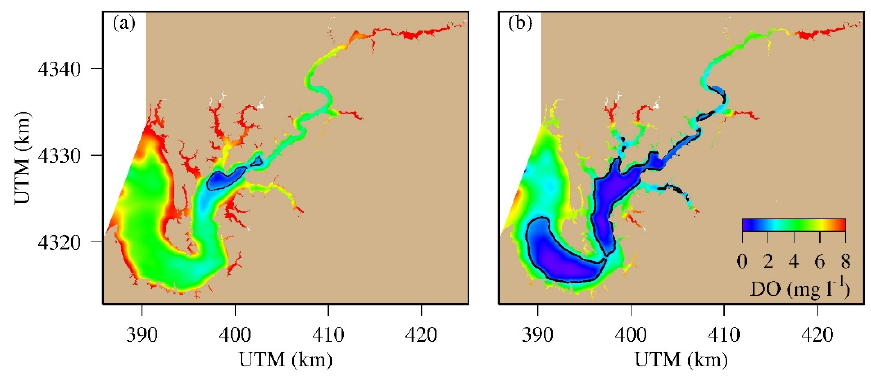
Figure 8. Spatial distribution of bottom DO and hypoxia (blue within the 2 mg L − 1 contour), ( a ) June 21 (low hypoxia) and ( b ) July 21 (high hypoxia), 2005.